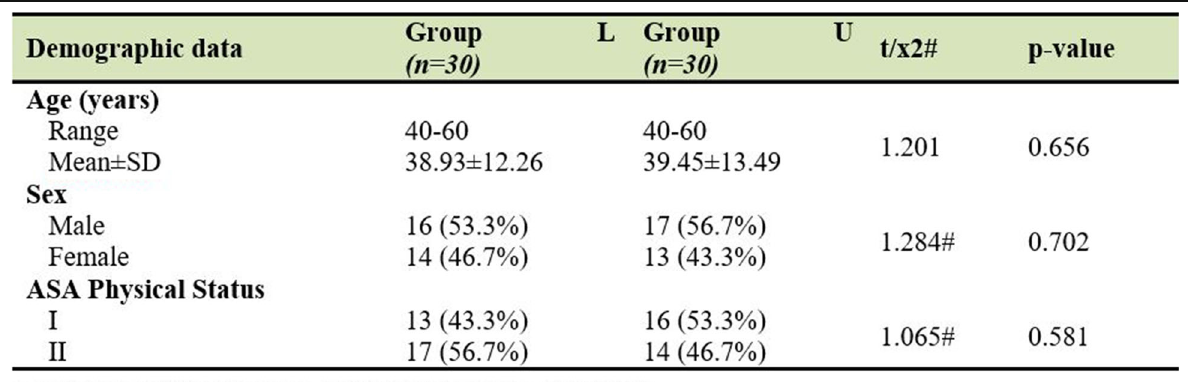
Table 1 Comparison between group L and group U as regards demographic